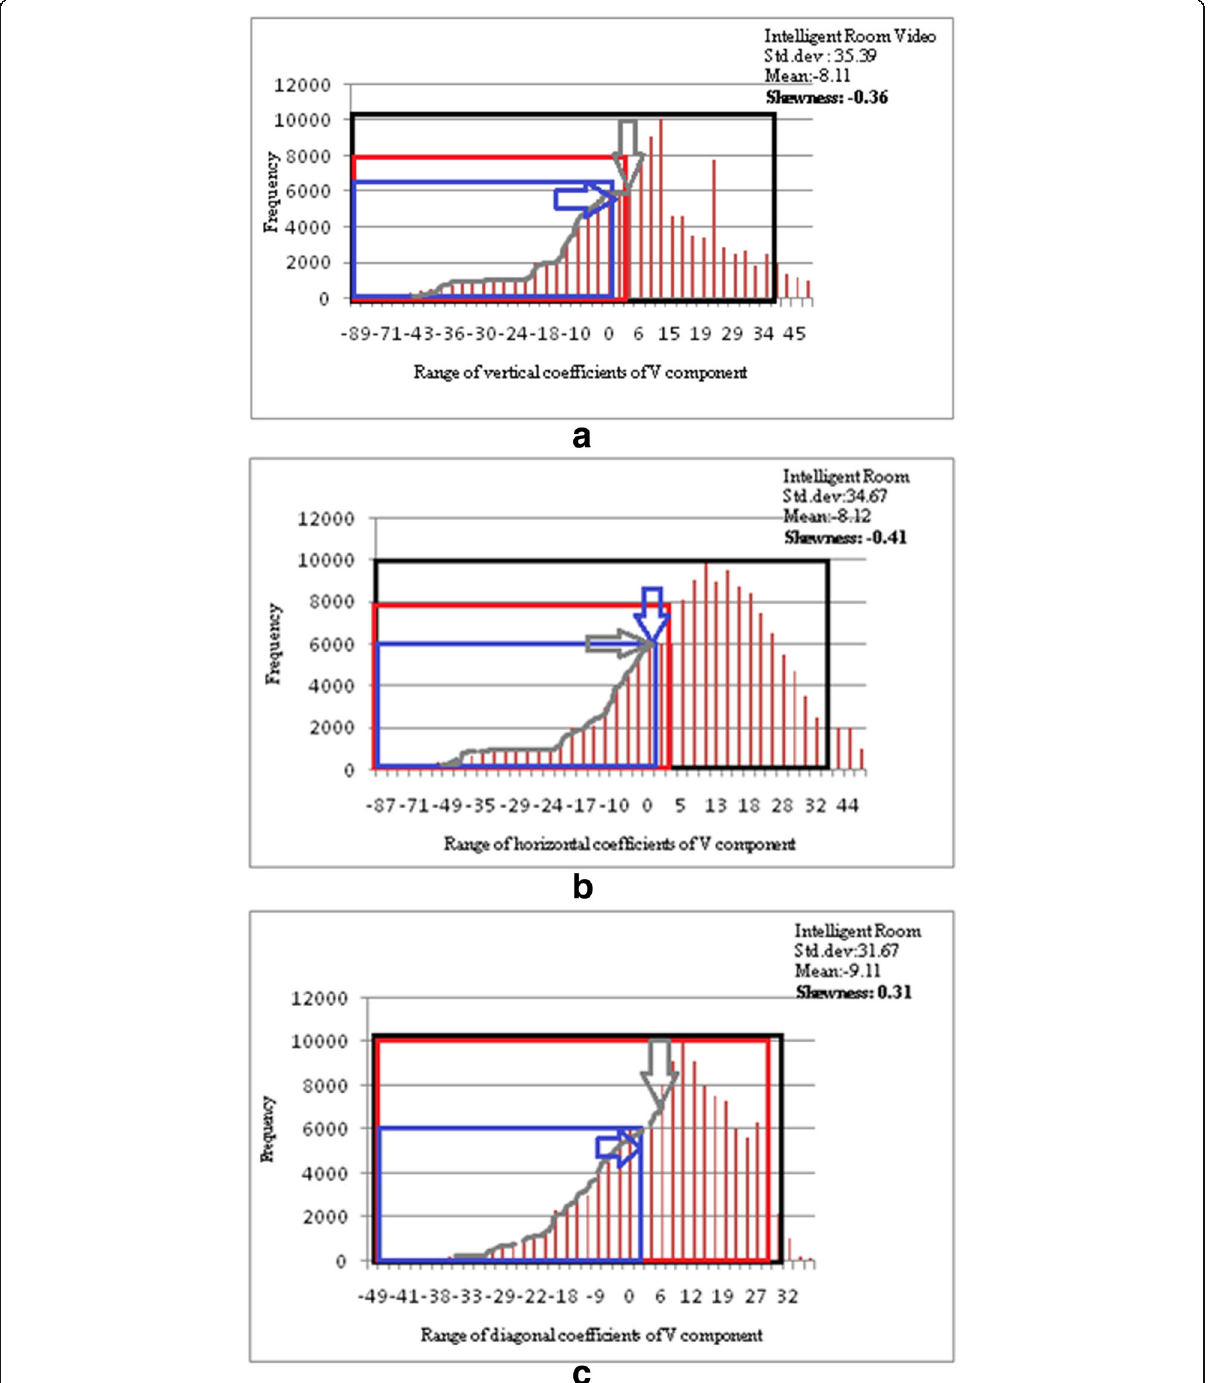
Fig. 5 Plot of a vertical, b horizontal and c diagonal wavelet coefficients of frame no. 130 from Intelligent Room video sequence: The grey colour line shows the original shadow pixels, and the arrow mark in grey colour indicates the end of the shadow points. The blue colour square indicates the detected shadow pixels using skewness, and the arrow mark in blue colour indicates the end of the shadow points. The black and red square s indicate the detected shadow pixels using standard deviation [26] ( σ ) and relative standard deviation [27] ( σ / μ